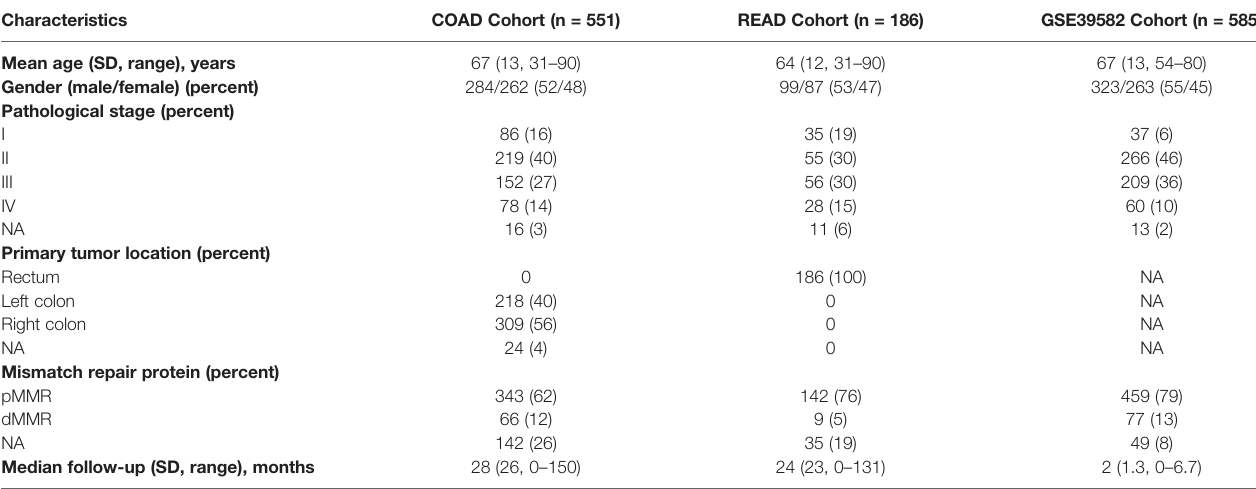
TABLE 2 | Clinicopathologic characteristics of the different sets for patients with colorectal cancer. Characteristics COAD Cohort (n =